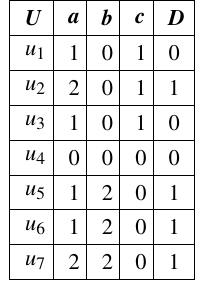
Table 1 A redundant decision table.